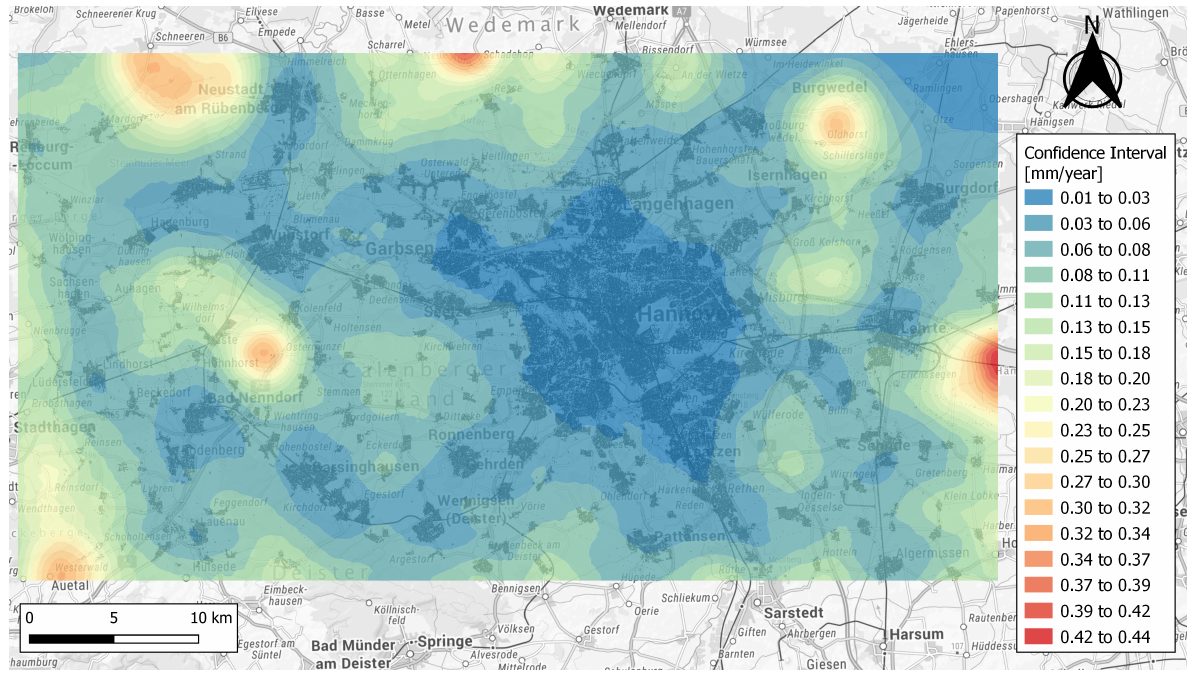
Figure 11. Heat map of the 95% percentile interval of the approximated RGM.The range of the CIs are color-coded. The black points represent the PSI